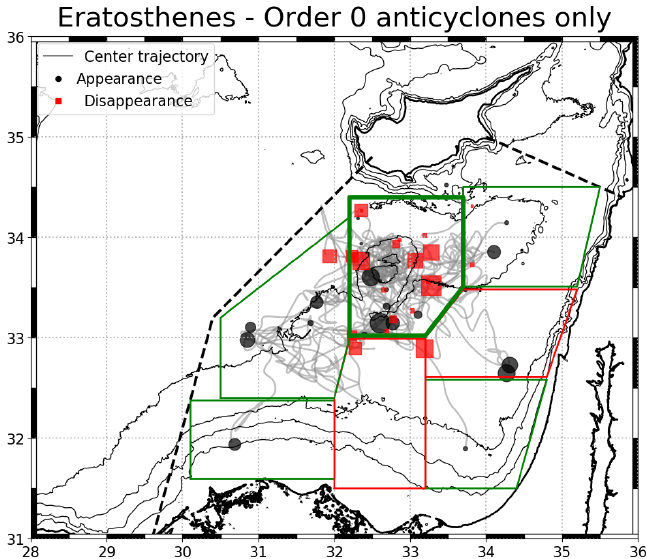
Figure A2. Appearance and disappearance locations for all order 0 anticyclones for the Eratosthenes region. Even if not all of them die within the region, they disappear very close to